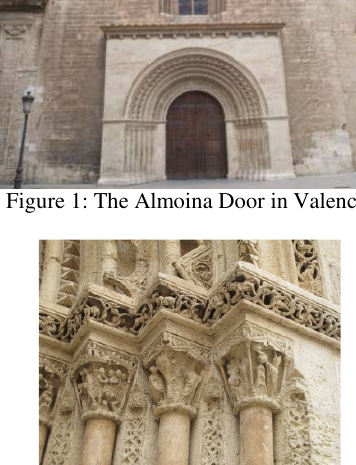
Figure 2: Detail of the complexity of the object to be described by a mesh photogrammetric tools combining terrestrial